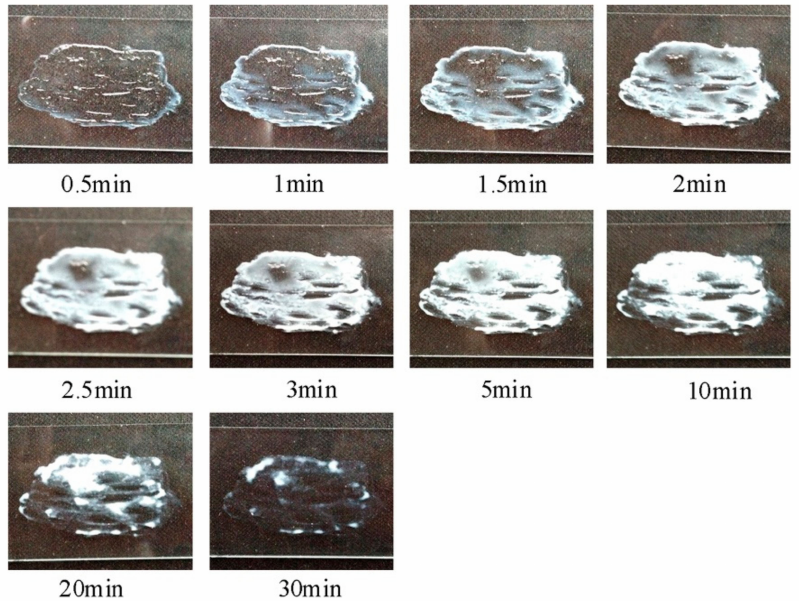
Figure 6. Real-time morphological changes during film-forming process of transparent hydrogels. Reprinted with permission from ref. [52]. Copyright 2014